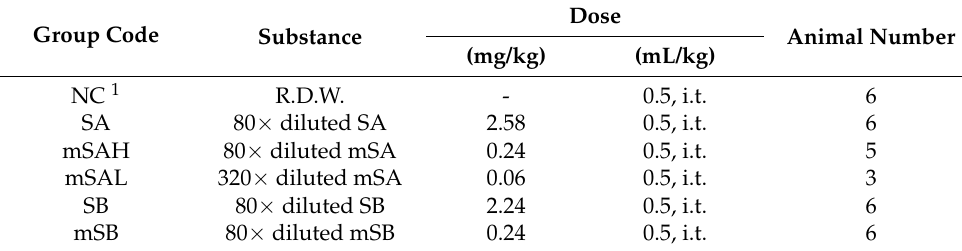
Table 2. Study design of nano-silica in the acute pulmonary toxicity.